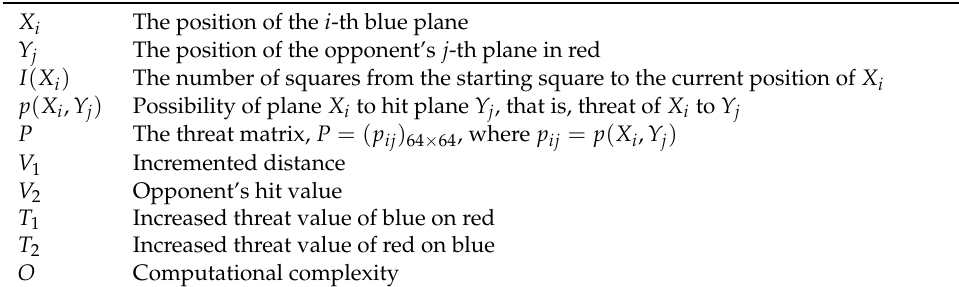
Table 1. Notations of the main